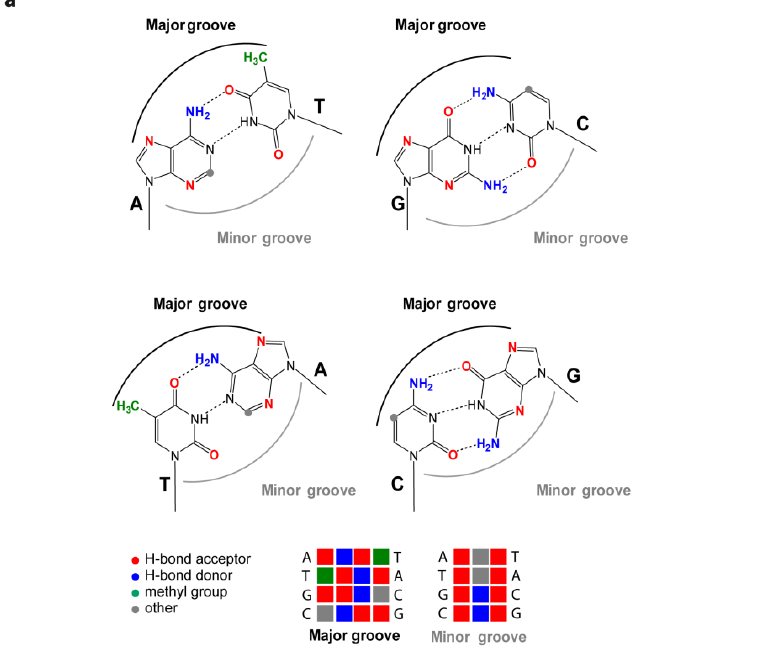
Figure 7. Base readout in the major and minor groove. ( a ) Functional groups of the DNA base pairs in the major and minor DNA groove; ( b ) Accessibility of functional groups in the major groove in a 16-mer B-DNA; ( c ) Locally increased readout accessibility in minor groove of bent B-DNA (PDB code 1JJ4); ( d ) Enlarged binding capability due to kink-induced shape alteration in B-DNA (PDB code 2KEI, [92]). Hydrogen bond donors in blue, acceptors in red and thymine methyl group in